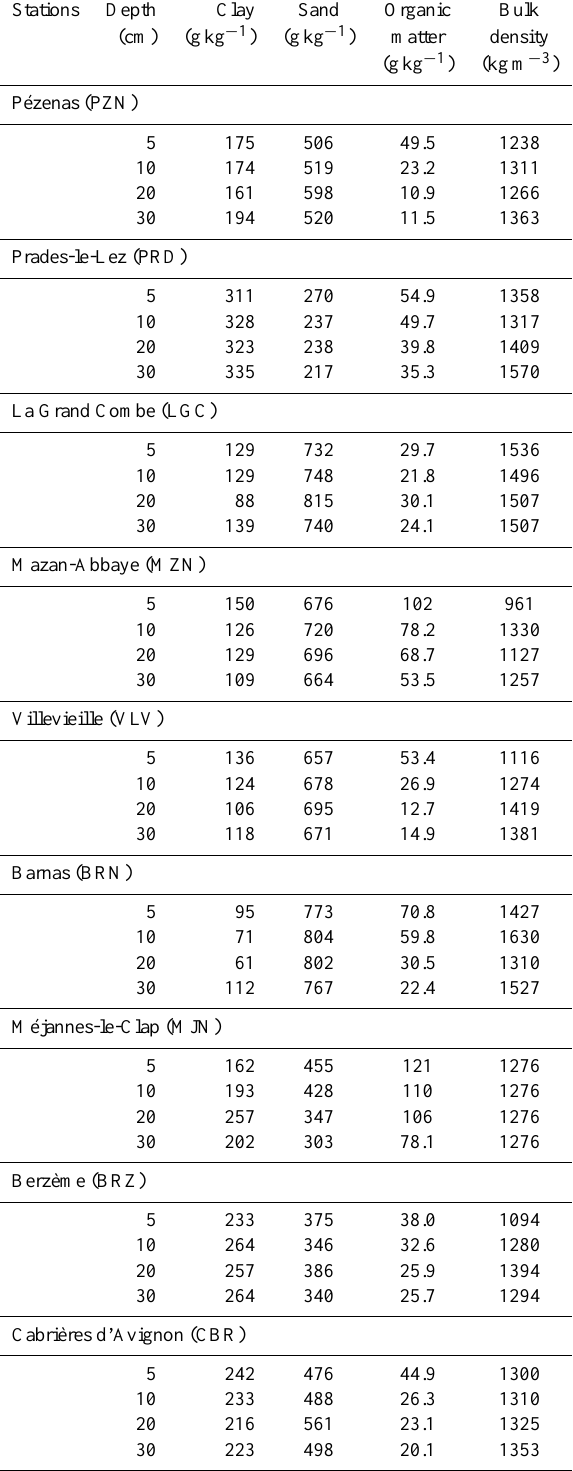
Table 1. Soil characteristics of the nine new stations of the SMOS- MANIA network at four depths (5, 10, 20 and 30cm): fractions of clay, sand fraction, organic matter, and bulk density. The station are listed from East to West (Pezenas to Cabri`eres